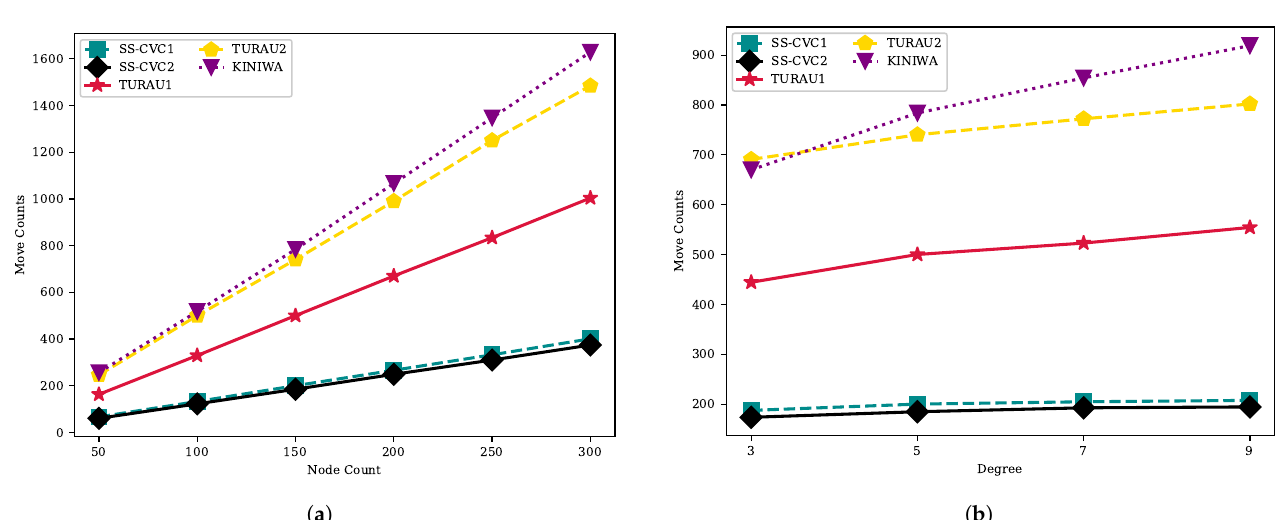
Figure 7. Move counts of algorithms on weighted networks: ( a ) Move count against node count on the fixed average degree 5; ( b ) Move count against node count on the fixed network size 150. The step count of SS-CVC 2 varies between 33 and 68, while SS-CVC 1 has less than 34 step counts, as shown in Figure 8a. KINIWA needs 78–148 steps to stabilize for each size of the graph. The algorithm that has the closest step count to our algorithm is TURAU 1 with 45 to 74 steps. Compared with TURAU 1 , the SS-CVC 1 and SS-CVC 2 algorithms need 1.10 and 2.15 times less steps, respectively, to stabilize. SS-CVC 1 and SS-CVC 2 are 4.22 and 2.17 times faster than KINIWA, respectively, which has the greatest step size for all graph sizes. As seen in Figure 8b, the step count of SS-CVC 1 stayed stable at around 28 as the density of the graph increased, while SS-CVC 2 ’s step count increased with the density. Starting with the average degree of 7, the SS-CVC 2 algorithm exceeds the TURAU 1 algorithm. However, in most graph types, the SS-CVC 1 and SS-CVC 2 algorithms outperformed other algorithms in terms of step count.